Question: In one sentence, what is this figure communicating?
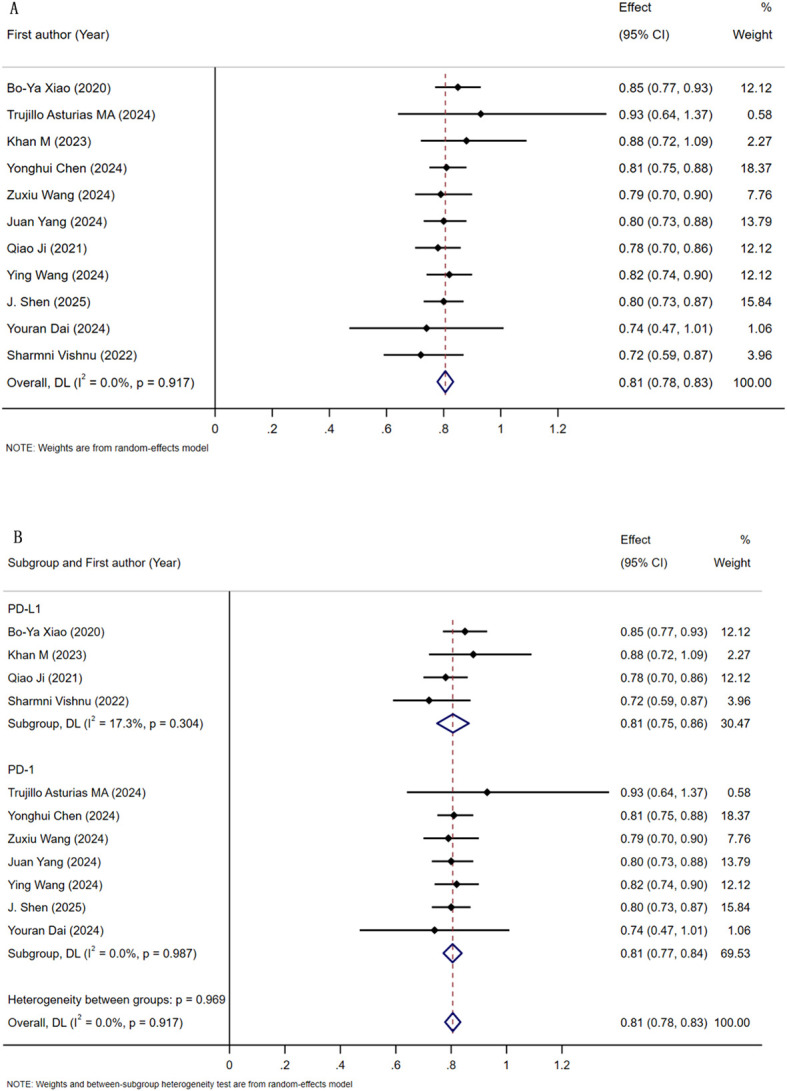
Answer: Forest plots of PFS in patients with advanced TNBC treated with ICIs plus chemotherapy. (A) Overall population; (B) Subgroup analyses stratified by ICI type (PD-1 vs. PD-L1 inhibitors).